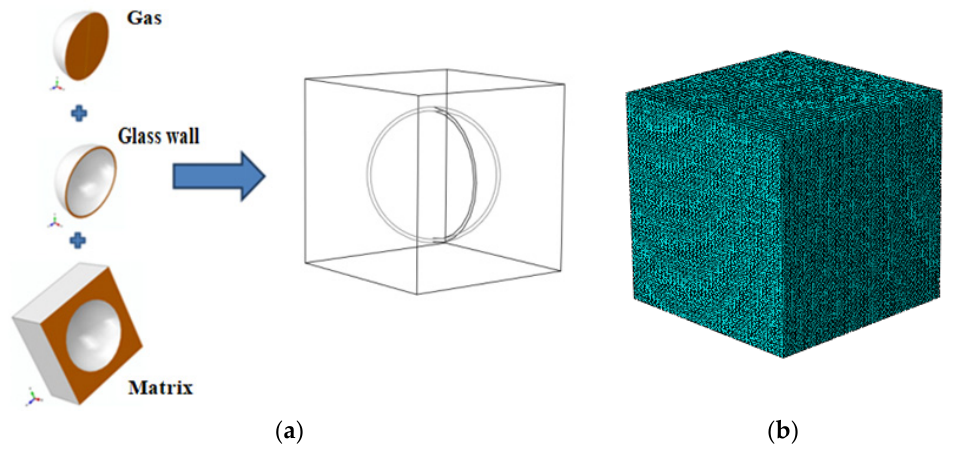
Figure 10. ( a ) The three-phase composite unit cell 1 and ( b ) the related mesh division.